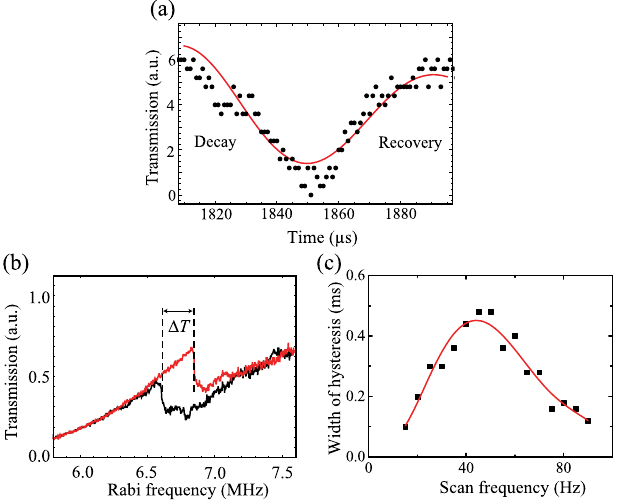
FIG. 10. (a) Details of an instability spike from Fig. 6(d). The fitted curve is based on a two-level system. (b) The phase transition as Ω is swept. The red (black) line corresponds to p the þ ( − ) scan direction, respectively. The detuning is set to Δ = 2 π ∼ − 15 MHz. (c) Hysteresis width of phase vs sweep c frequency.